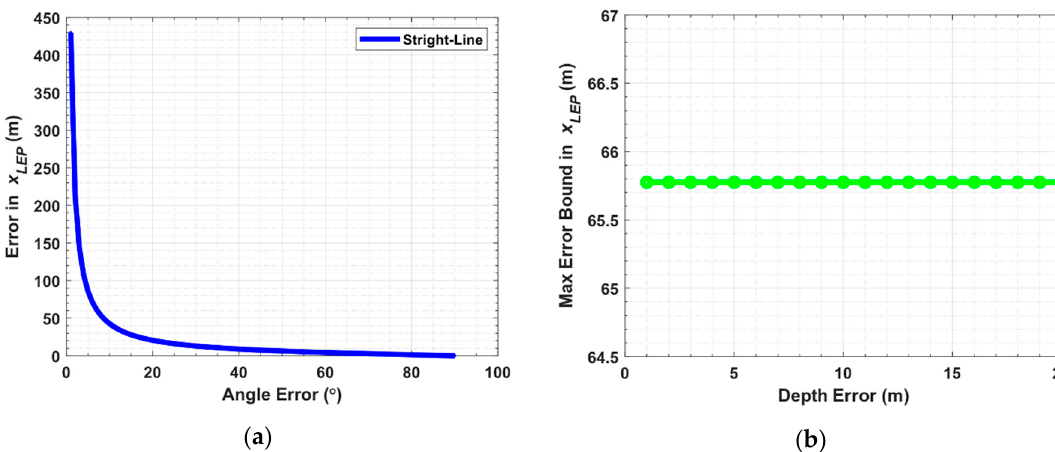
Figure 13. The classification error trend when the angle of transmission and depth are subjected to an additive gaussian error with zero mean and standard deviation depicted on the 𝑥 - axis.